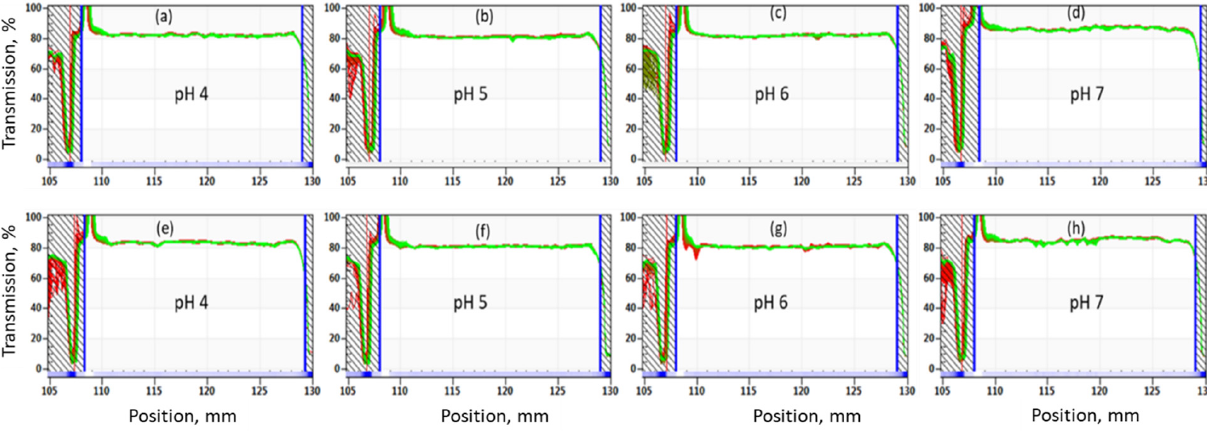
Figure 9. Accelerated stability analysis at 60 °C for 1 wt.% OF50-M in SSW at ( a , e ) pH 4, (b, f ) pH 5, (c, g ) pH 6, and ( d , h ) pH 7. The simulated stability duration was 6 months and runtime of experiment was 31 h. Samples were run in duplicate. The results of DLS measurements for OF50-M are shown in Table 3. It can be ob- served that the sizes of the nanoparticles were nearly the same in SSW and 3.5% NaCl brine. This indicates that the colloidal stability of modified nanoparticles was not affected by the presence of divalent ions in SSW. This combined effect of steric and electrosteric stabilizations imposed by GLYMO and SBS, respectively, is the key factor for enhanced stability of silica nanodispersions stability in high salinity brines. The particle size of sam- ples that were subjected to turbidity scan (for 7 days) and accelerated stability analysis at 60 °C only marginally increased at pH 6 and 7, which further validates good stability of OF50-M particles in high salinity brine at high temperature.